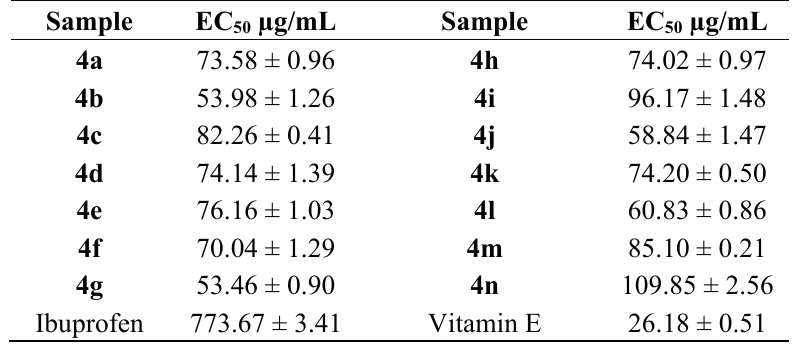
Table 3. Total antioxidant activity (EC 50 µg/mL) of the thiazolidine-4-one derivatives 4a – n